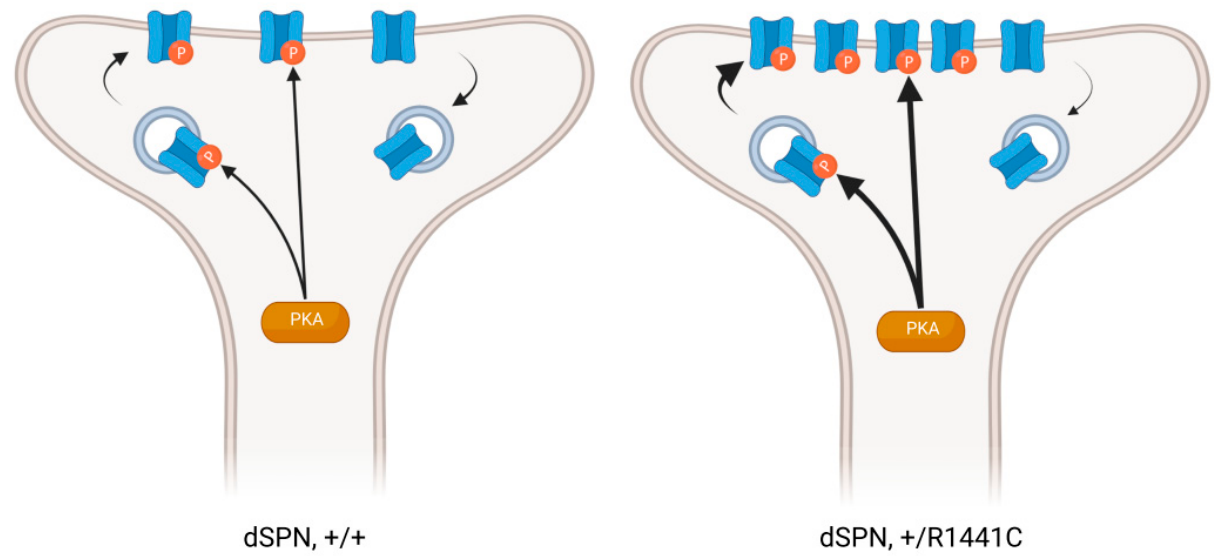
Figure 2. Pathway-specific effect of LRRK2 on synaptic AMPARs. The R1441C mutation induces an enhanced phosphorylation of GluR1 by PKA, leading to the increased insertion and retention of AMPA receptors into the synaptic membrane of dSPNs, but not iSPNs [78]. This figure was created using biorender.com.